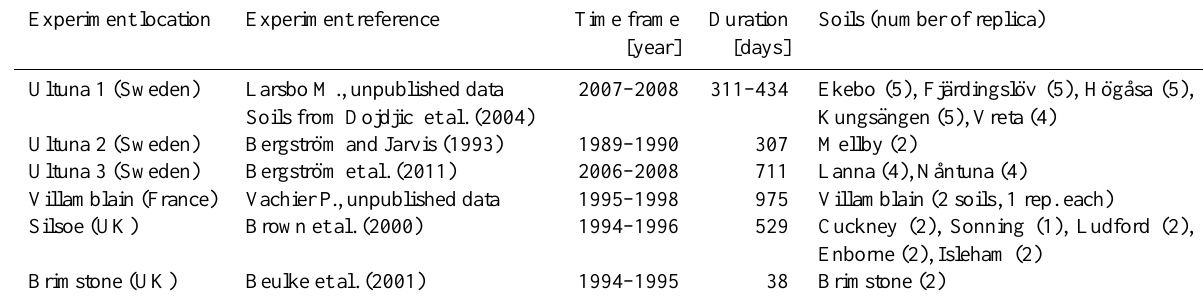
Table 1. Characteristics of the lysimeter experiments used for assessing MACRO and FOOTPRINT estimation algorithms.